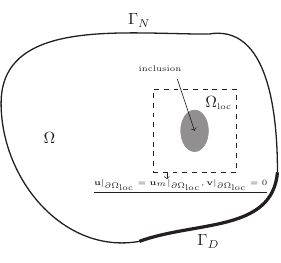
Figure 2. Illustration of the localization of the small anomaly in certain